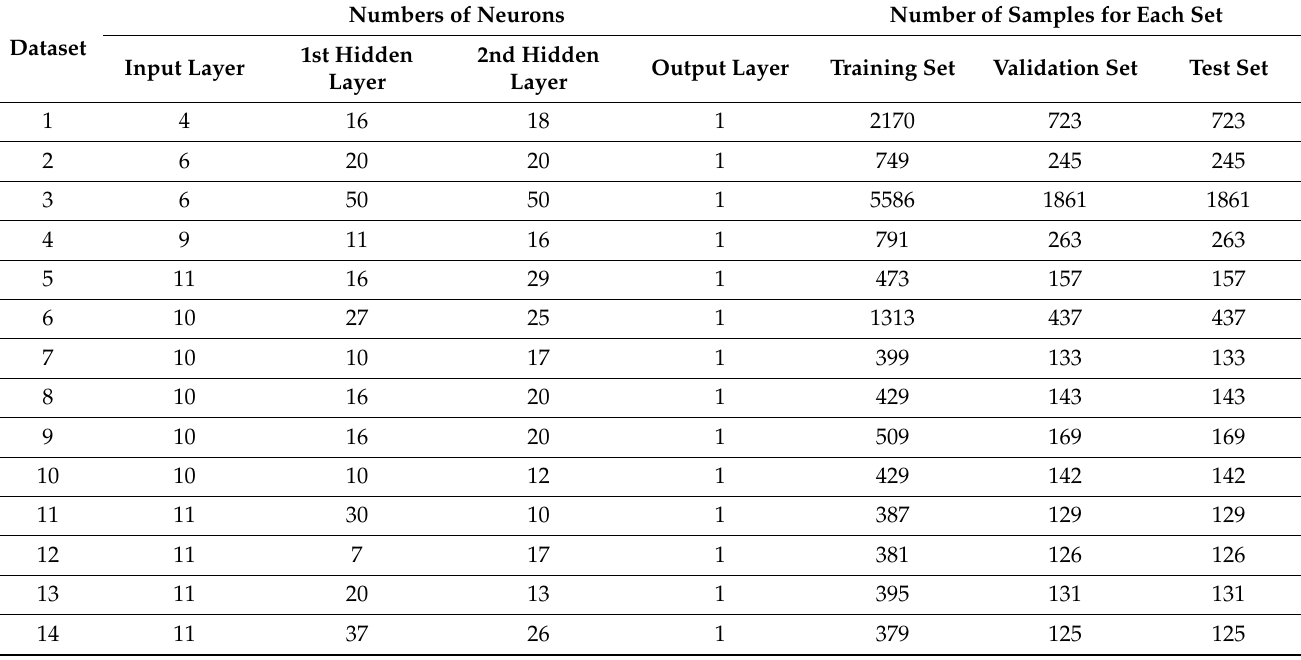
Figure 7. R-squared for the neural network model with two hidden layers. We identified the optimal structure for each dataset with two hidden layers after modeling the MLP network and making the necessary adjustments. Table 8 summarizes the obtained results. Table 8. Optimized parameters for the final model for the MLP model with two hidden layers.